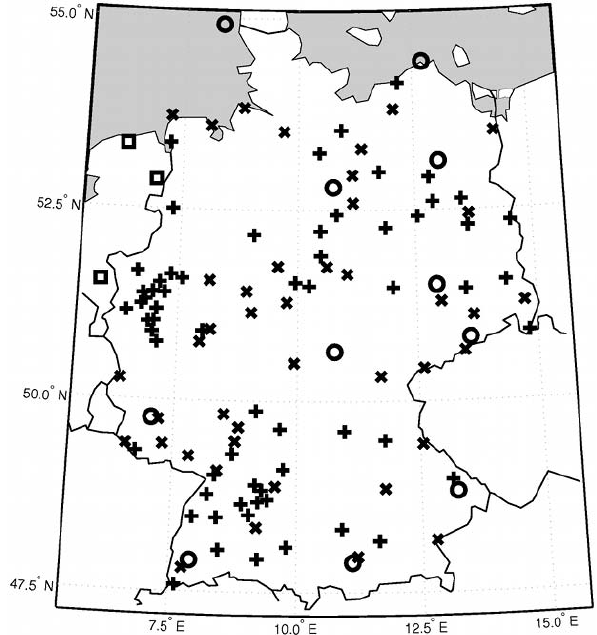
Fig. 3. Map of observational station locations: PM 10 concentra- tions (rural background) (x), PM 10 concentrations (suburban back- ground) (+), SIA concentrations ( (cid:3) ), wet deposition fluxes